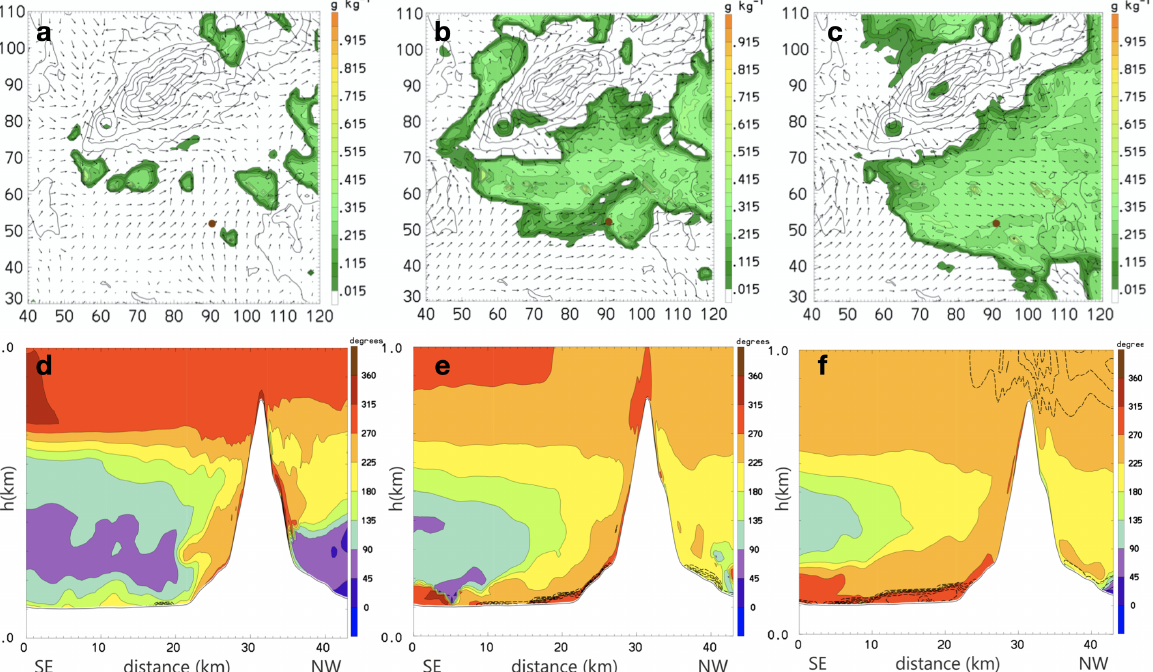
Figure 4. Katabatic event developing during the clear-skies interval of night 27–28 January 2018. Top: horizontal vector and cloud water (colour) at the first model level (( a ) 00 UTC, ( b ) 01 UTC, ( c ) 02 UTC). Bottom: wind direction (colours) and cloud water (dashed lines) along the same line (( d ) 00 UTC, ( e ) 01 UTC, ( f ) 02